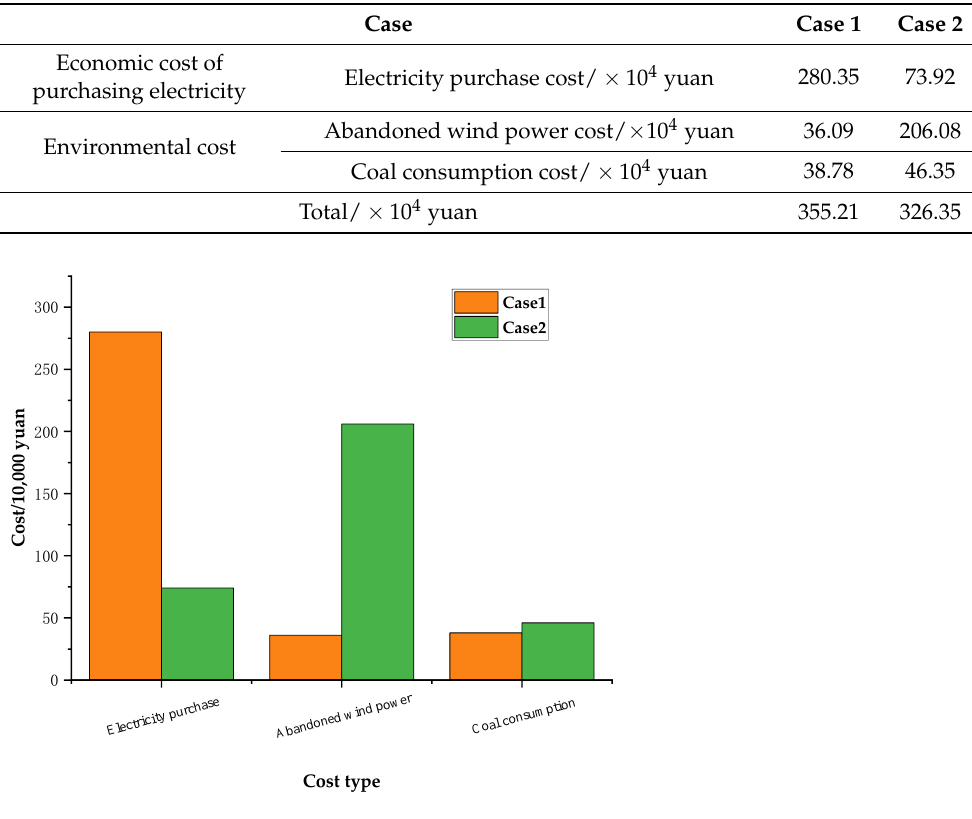
Figure 7. Cost distribution of two cases.